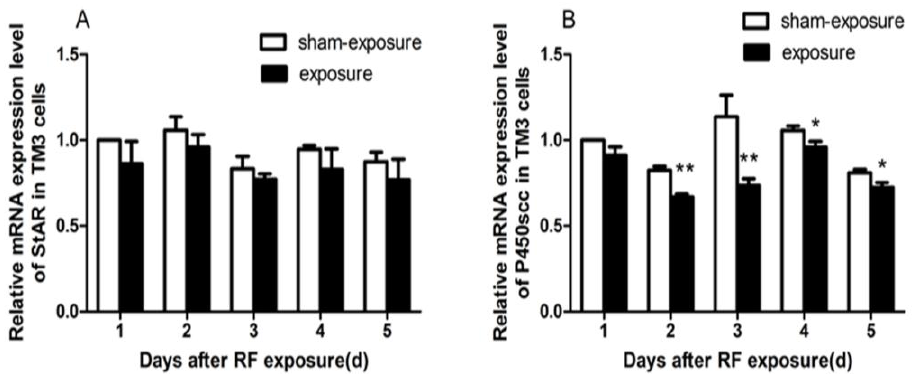
Figure 5. Effects of RF-EMR on mRNA expression of StAR and P450scc.( A ) Relative mRNA expression levels of StAR induced by RF-EMR in TM3 cells; ( B ) Relative mRNA expression levels of P450scc induced by RF-EMR in TM3 cells. Values represent mean ± SEM for each of the exposure and sham-exposure groups at each time point. ** p < 0.01 vs. sham-exposure (Student t -test), * p < 0.05 vs. sham-exposure (Student t -test).